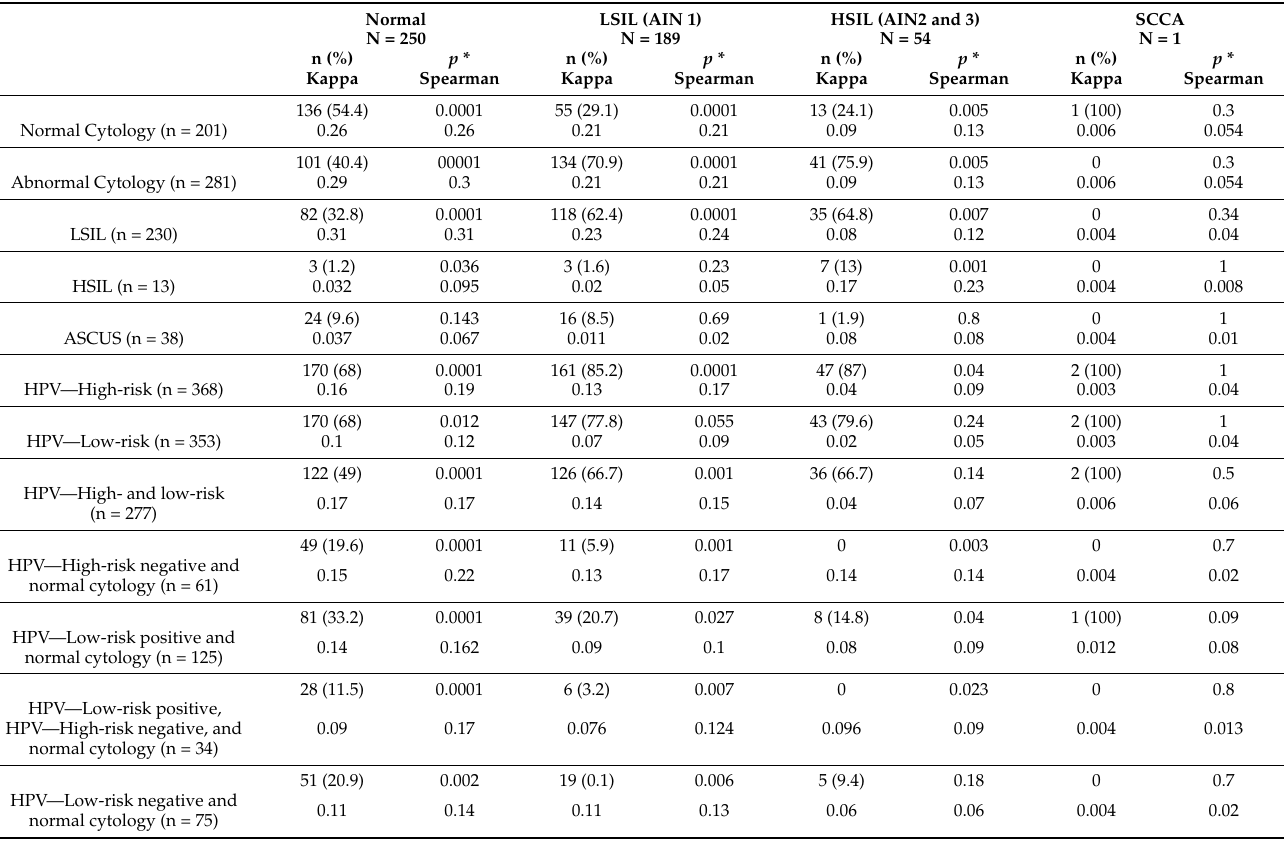
Table 6. Correlation of anal HPV cytology and PCR with histology.